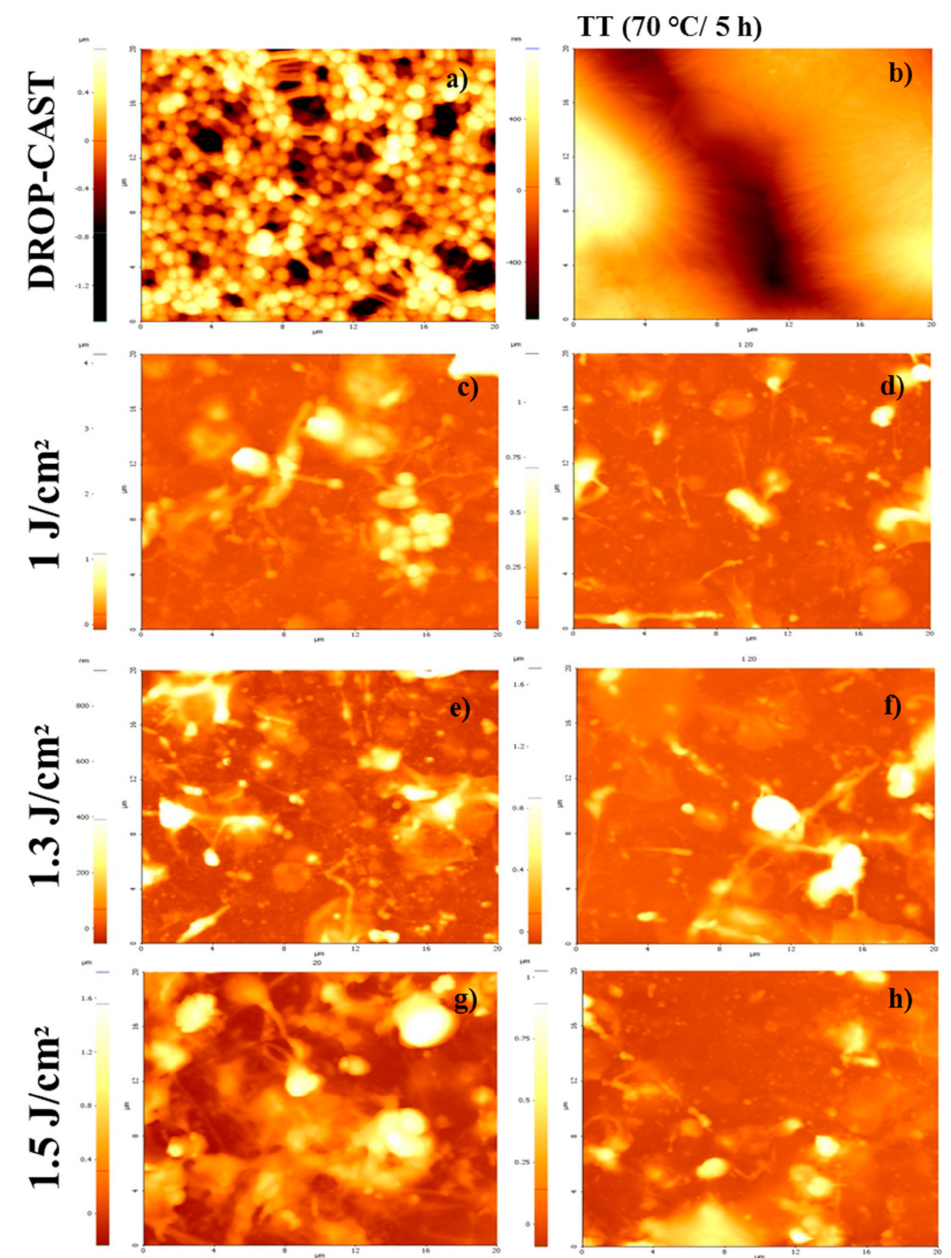
Figure 3. Atomic force microscopy (AFM) surface morphology images of PVDF thin films (20 × 20 µ m 2 ). Comparison between PVDF bulk, with ( a ) drop-cast; ( b ) drop-cast-TT, and the MAPLE-deposited samples at di ff erent fluences: ( c ) 1.0 J / cm 2 , ( e ) 1.3 J / cm 2 , ( g ) 1.5 J / cm 2 . In addition, the thermally-treated variant of the MAPLE-deposited films at ( d ) 1.0 J / cm 2 + TT, ( f ) 1.3 J / cm 2 + TT, and ( h ) 1.5 J / cm 2 +